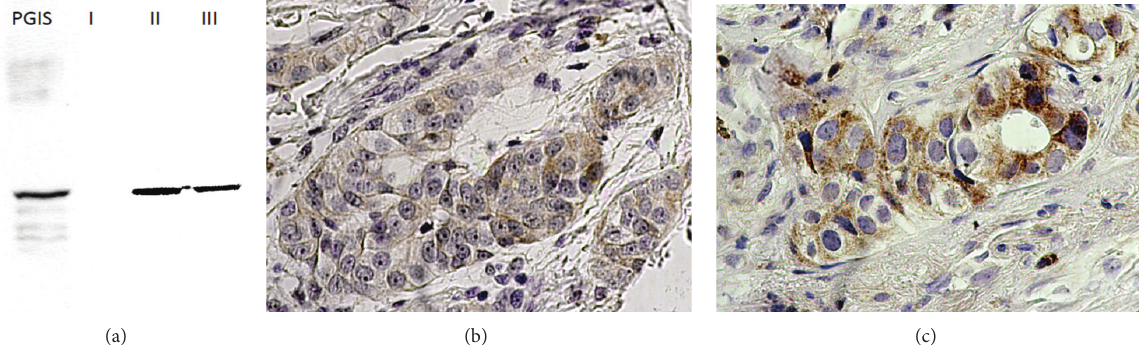
Figure 1: Immunological detection of prostacyclin-synthase. (a) Western blot analysis of MCF-7 cells transfected with control vector (lane I: pCDNA 3.1), wild-type (lane II: pCDNA3.1mPGIS), and mutant prostacyclin-synthase (lane III; pCDNA3.1 mPGISC441A). As positive control PGIS from bovine aorta is shown on the left. ((b), (c)) Expression of immunoreactive PGIS in tumor cells of a ductal carcinoma showing moderate (b) or intense labeling (c). Slides were photographed at 63x